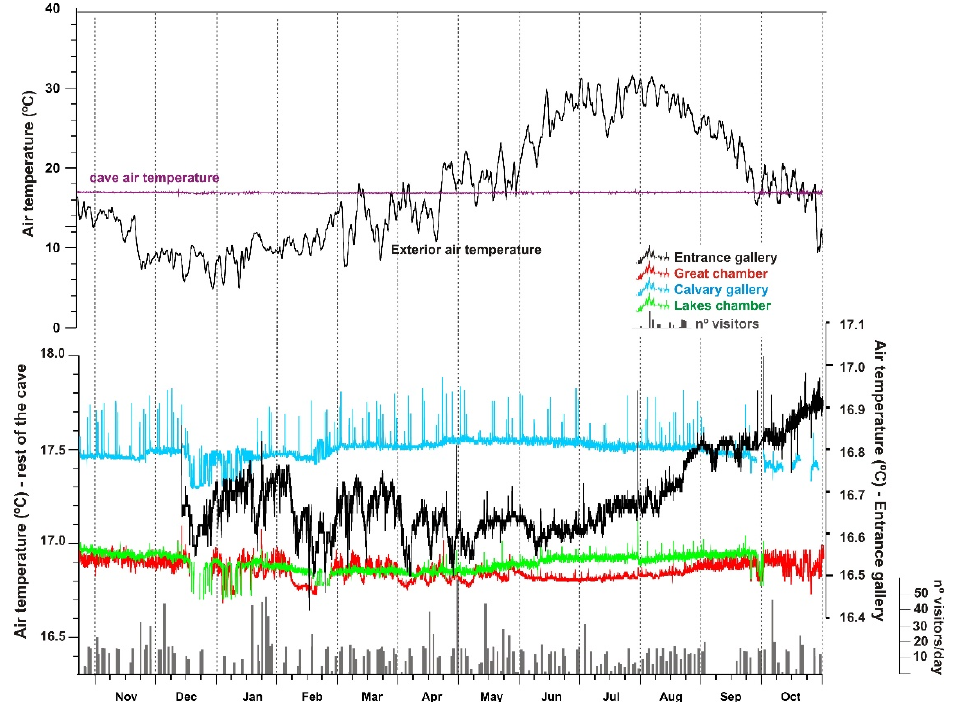
Figure 3. Air temperature at each monitoring station compared to the thermal difference between the exterior and the averaged cave temperature. Daily visits are also plotted to reveal the impacts on air temperature in the Calvary gallery.